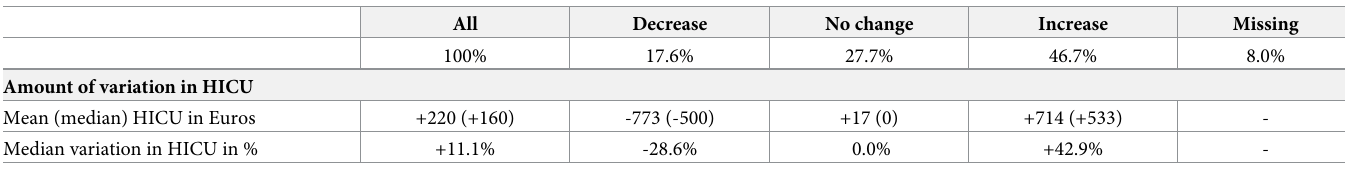
Table 1. Variation in HICU between diagnosis and survey (N =